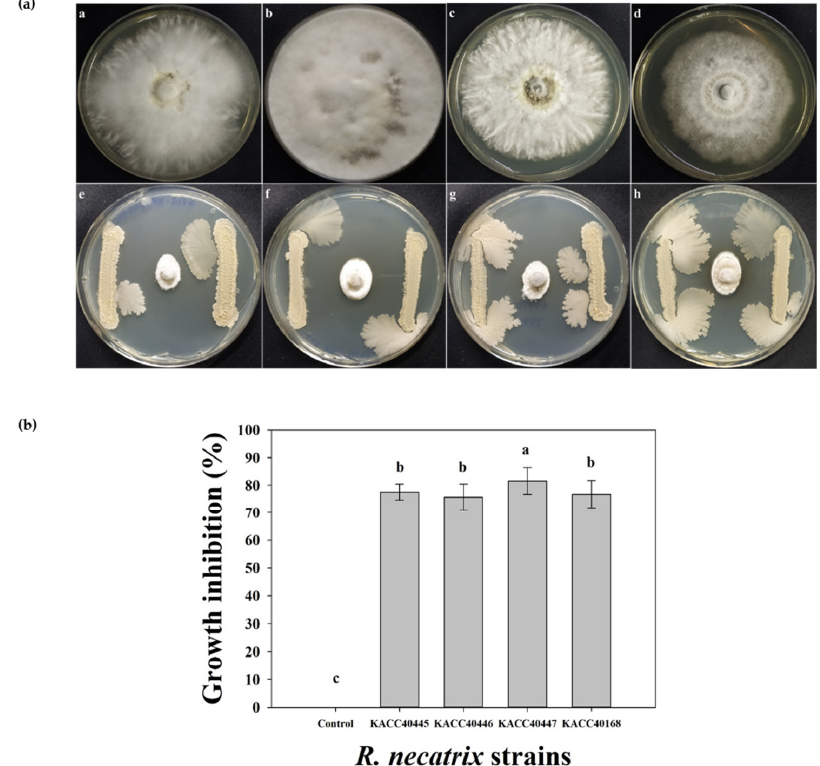
Figure 2. Antifungal activities of the isolated Bacillus velezensis RDA1 against four different strains of R. necatrix fungi KACC 40445, 40446, 40447, and 40168 in vitro. ( a ) A 5 mm fungus plug was inoculated into the center of the potato dextrose agar (PDA) medium and dual-culture plate assay. Plates a, b, c, and d are the controls for R. necatrix fungi KACC 40445, 40446, 40447, and 40168, re- spectively. Plates e, f, g, and h contain dual cultures of RDA1 and fungal pathogens. ( b ) Antifungal activities were measured based on the size of the zones of inhibition of the pathogenic fungi. Zones of inhibition were expressed as percentages. Vertical bars indicate ± standard deviation ( n = 9). Dif- ferent lowercase letters above each bar indicate significantly different means, as determined using Duncan’s multiple range tests.